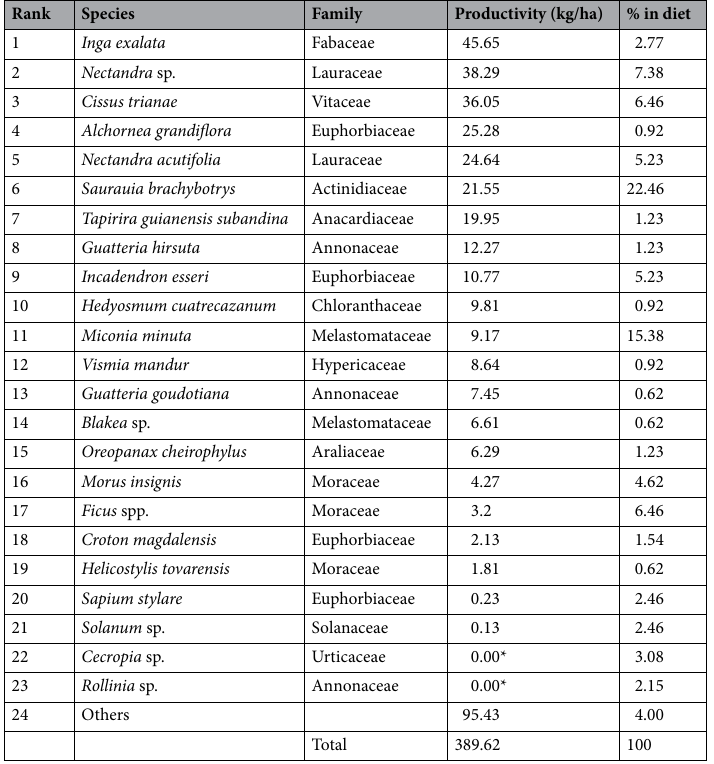
Table 1. Top fruiting species productivity and how much is included in the woolly monkeys’ ( Lagothrix lagotricha lugens ) diet during the study period at Cueva de los Guácharos National Park. Fruiting species with an asterisk (*) point out that were present in the diet of the monkeys but we were not able to detect them in our fruit hanging